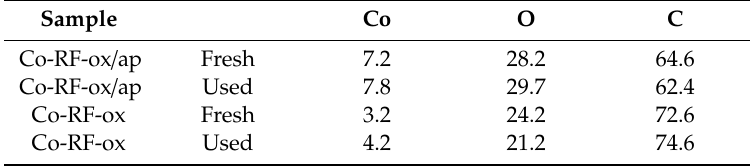
Table 2. Surface composition of selected catalysts determined by XPS (at.%). Sample Co O